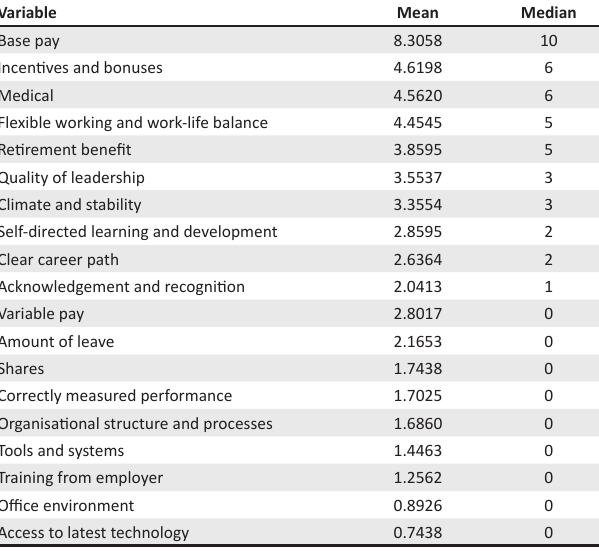
TABLE 6: Summary of rank scores for attraction.